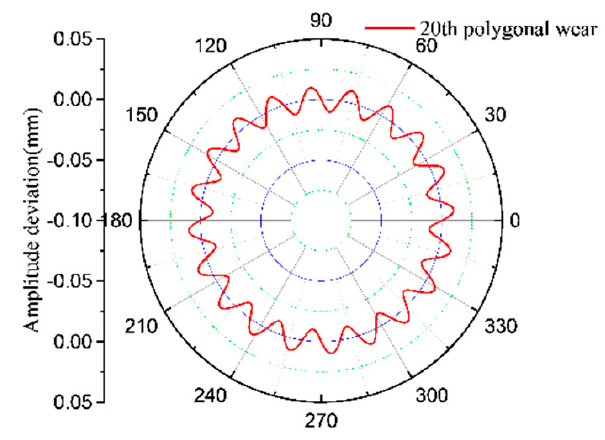
Figure 10. Wheel polygonization used in simulation.